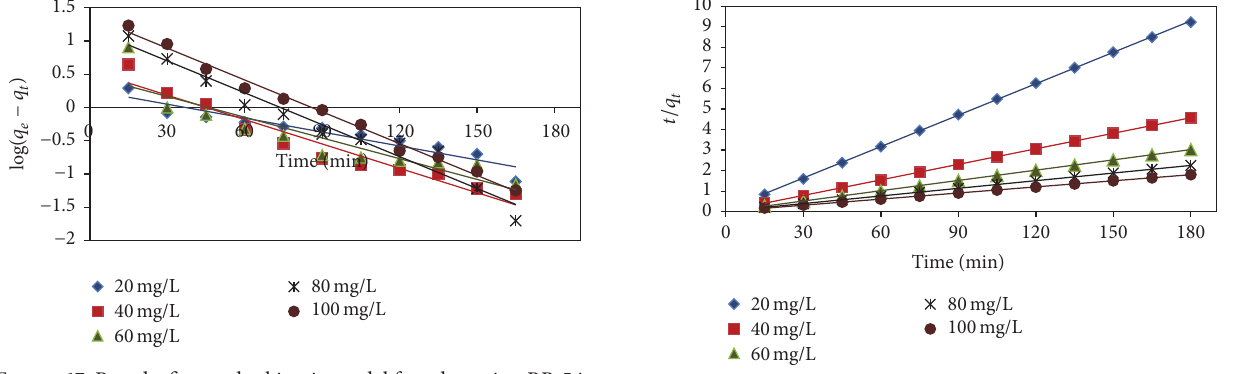
Figure 19: Pseudo-second-order kinetic model for adsorption RB-5 in binary system with RR-RB (temp. = 25 ∘ C, speed = 200 rpm, dose = 0.1 g/100mL, and con. of RR-RB = con. of RB-5).